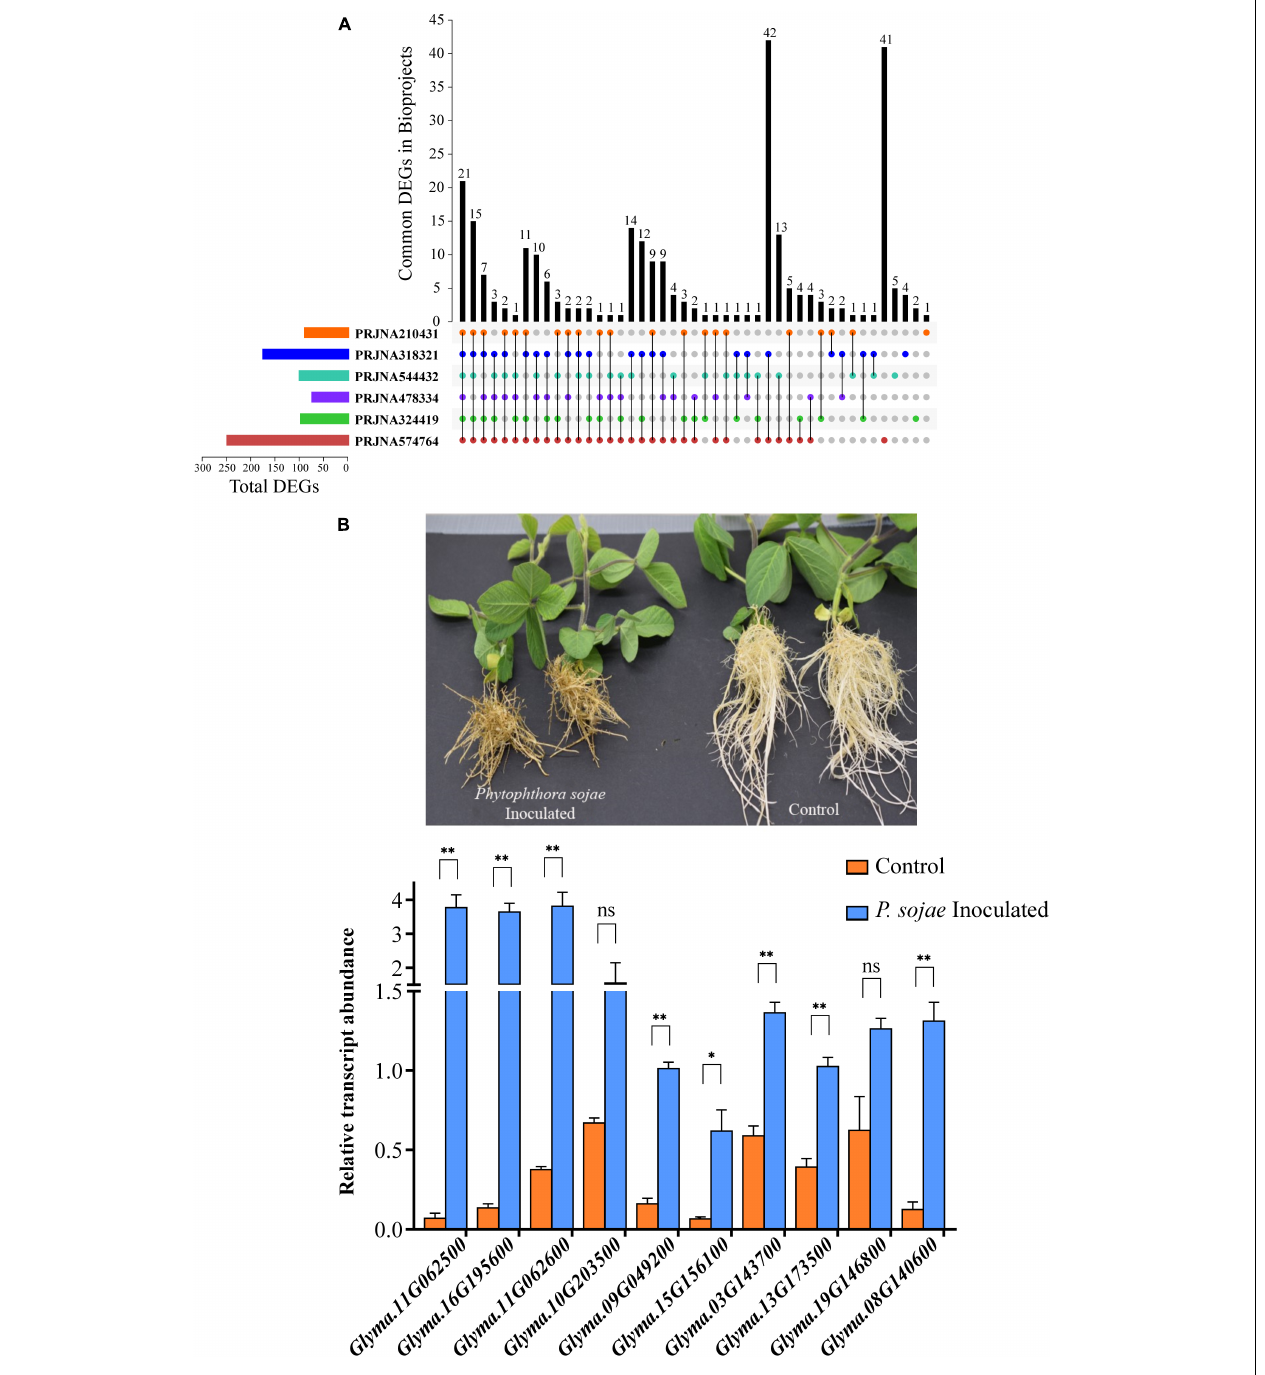
FIGURE 7 | The expression analysis of GmP450 upon exposure to P. sojae . (A) An UpSet diagram depicting the expression of GmP450 genes that are common or unique in the bioprojects used in this study. RNAseq datasets on soybean– P. sojae interaction available in public domain (bioprojects: PRJNA324419, PRJNA544432, PRJNA210431, PRJNA318321, PRJNA478334, and PRJNA574764) were retrieved and differentially expressed GmP450 s in each datasets were used in pair-wise overlap. A number of differentially expressed GmP450 s upon P. sojae infection either unique to a dataset or common between the datasets are shown. (B) A photograph of soybean cv. Misty seedlings control (mock infected) or 21 days after P. sojae infection (top). The disease symptoms can be clearly seen on infected plant roots as brownish lesions. The bottom graph shows the expression analysis of ten GmP450 genes in soybean root tissues collected after 24 h of P. sojae infection. cDNA was synthesized from total RNA (1 µ g) from P. sojae -infected and control soybean roots, and qPCR was performed using gene-specific primers. Expression values were normalized against the reference gene CONS4 . The error bars represent the SEM of two biological replicates and three technical replicates for each biological replicate. Asterisks represent the significant differences with the control samples at p < 0.05 ( ∗ ) or p < 0.01 ( ∗∗ ). ns indicates not significant ( p > 0.05).